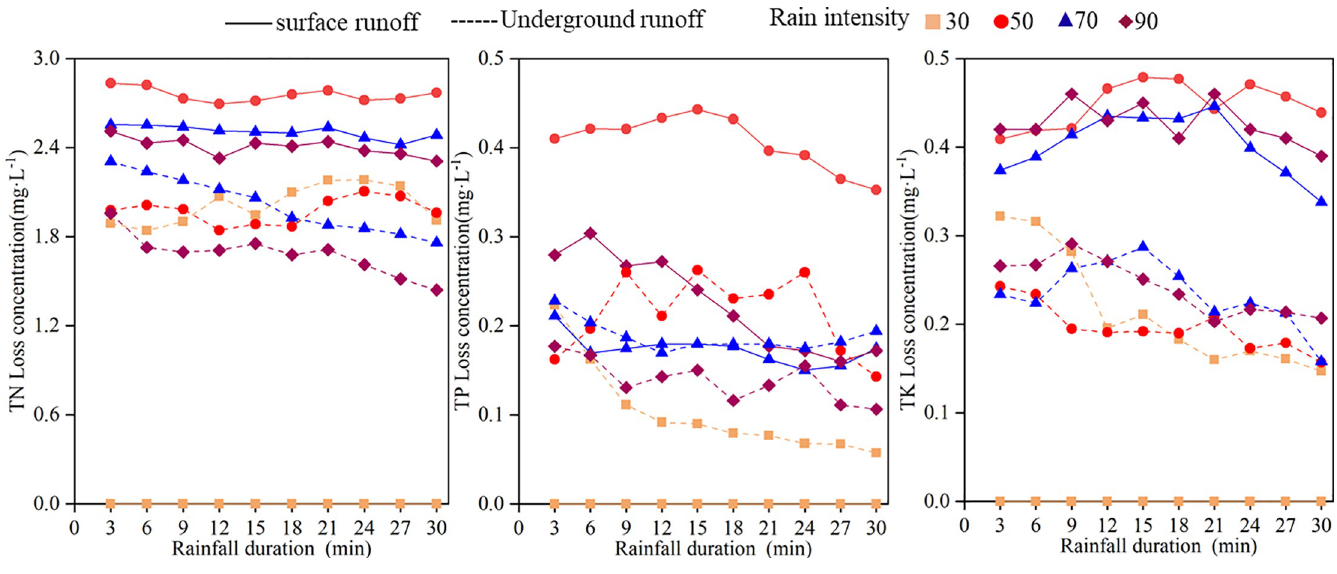
Fig 6. Variation of runoff nutrient concentrations with rainfall duration.